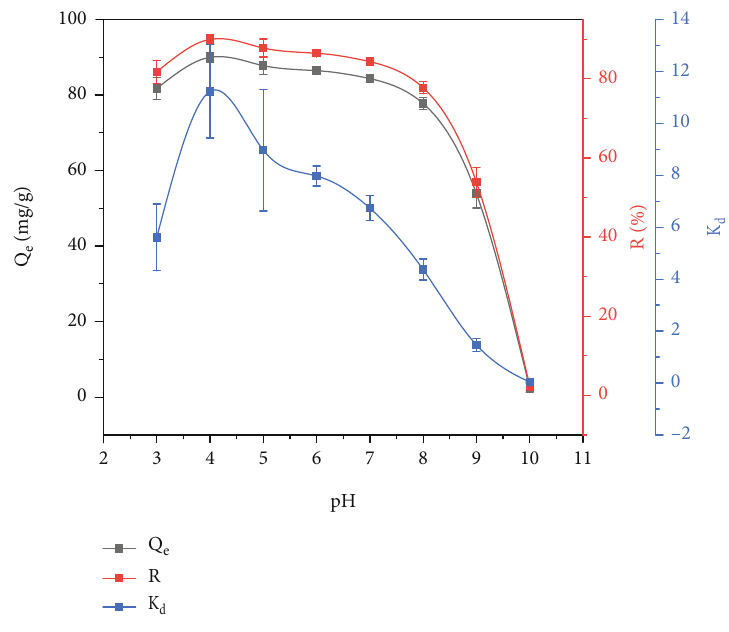
Figure 7: E ff ect of pH change on the adsorption of GO by red sandstone.